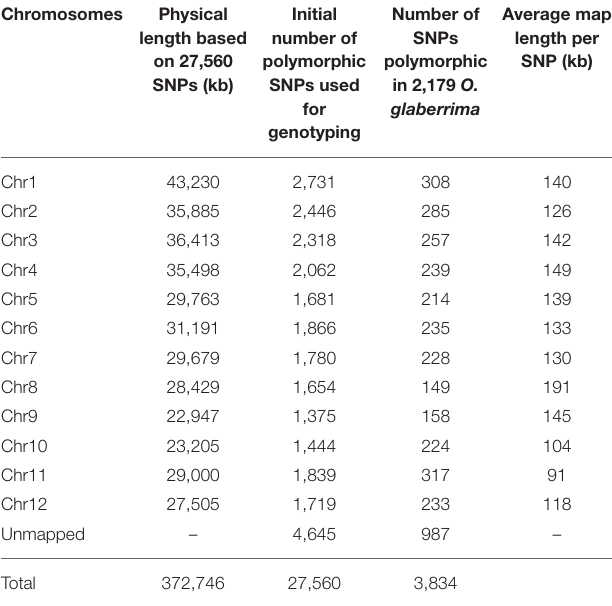
TABLE 1 | The chromosomal distribution of 3,834 polymorphic SNPs used for genotyping 2,179 O. glaberrima accessions, including the physical length of each chromosome covered by the SNPs (in kilobase pairs) and the average distance between SNPs.